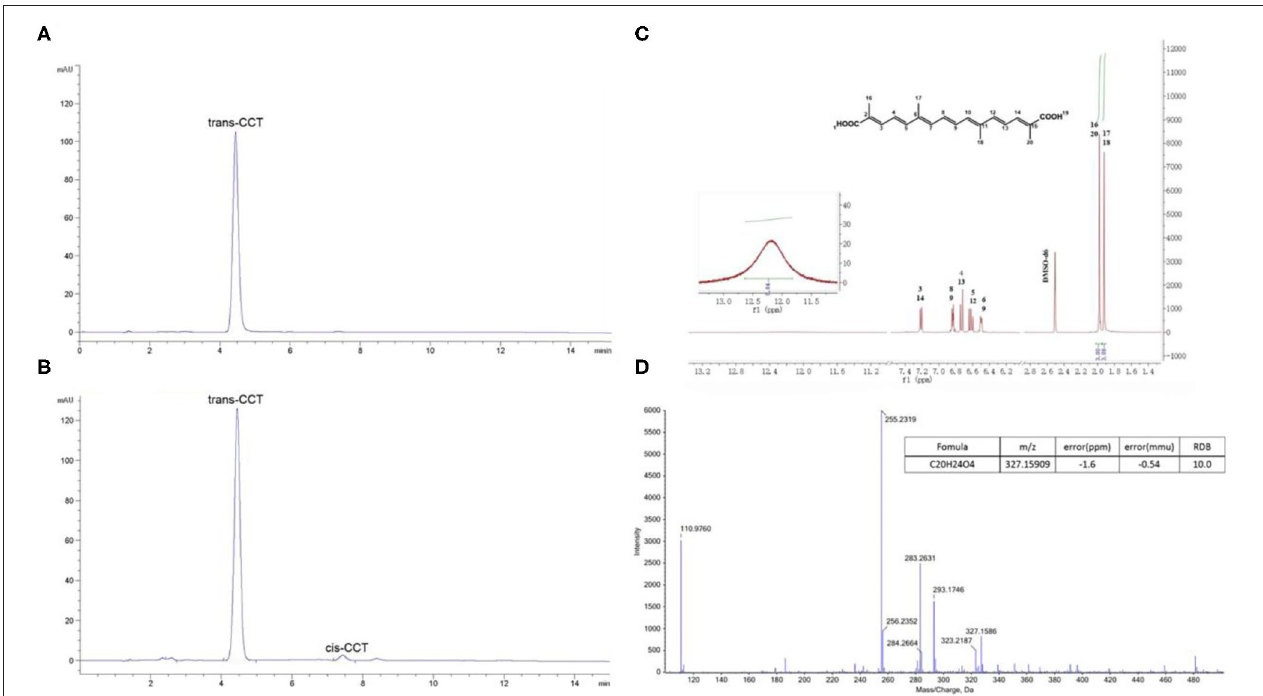
FIGURE 2 | The purity and structure analysis of CCT. (A) HPLC chromatogram of CCT reference substance. (B) HPLC chromatogram of CCT. (C) 1 H-NMR of CCT. (D) (-) ESI-MS/MS of CCT.